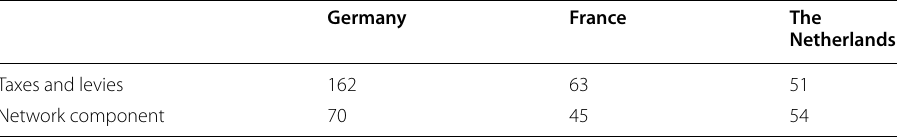
Values are in € /MWh